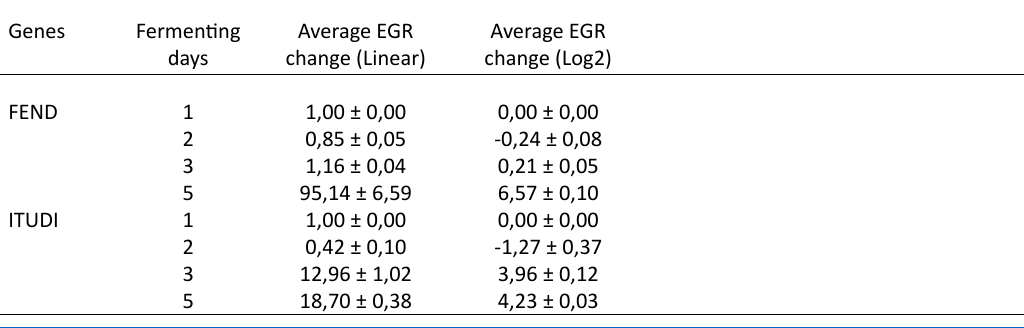
B. megaterium vs. Alternaria sp. B. megaterium vs. Botrytis sp. Table 4. 16S gene amplification curve, FEND, ITUDI of Bacillus megaterium versus Botrytis sp., at day 5 (LightCycler®, Roche) Genes